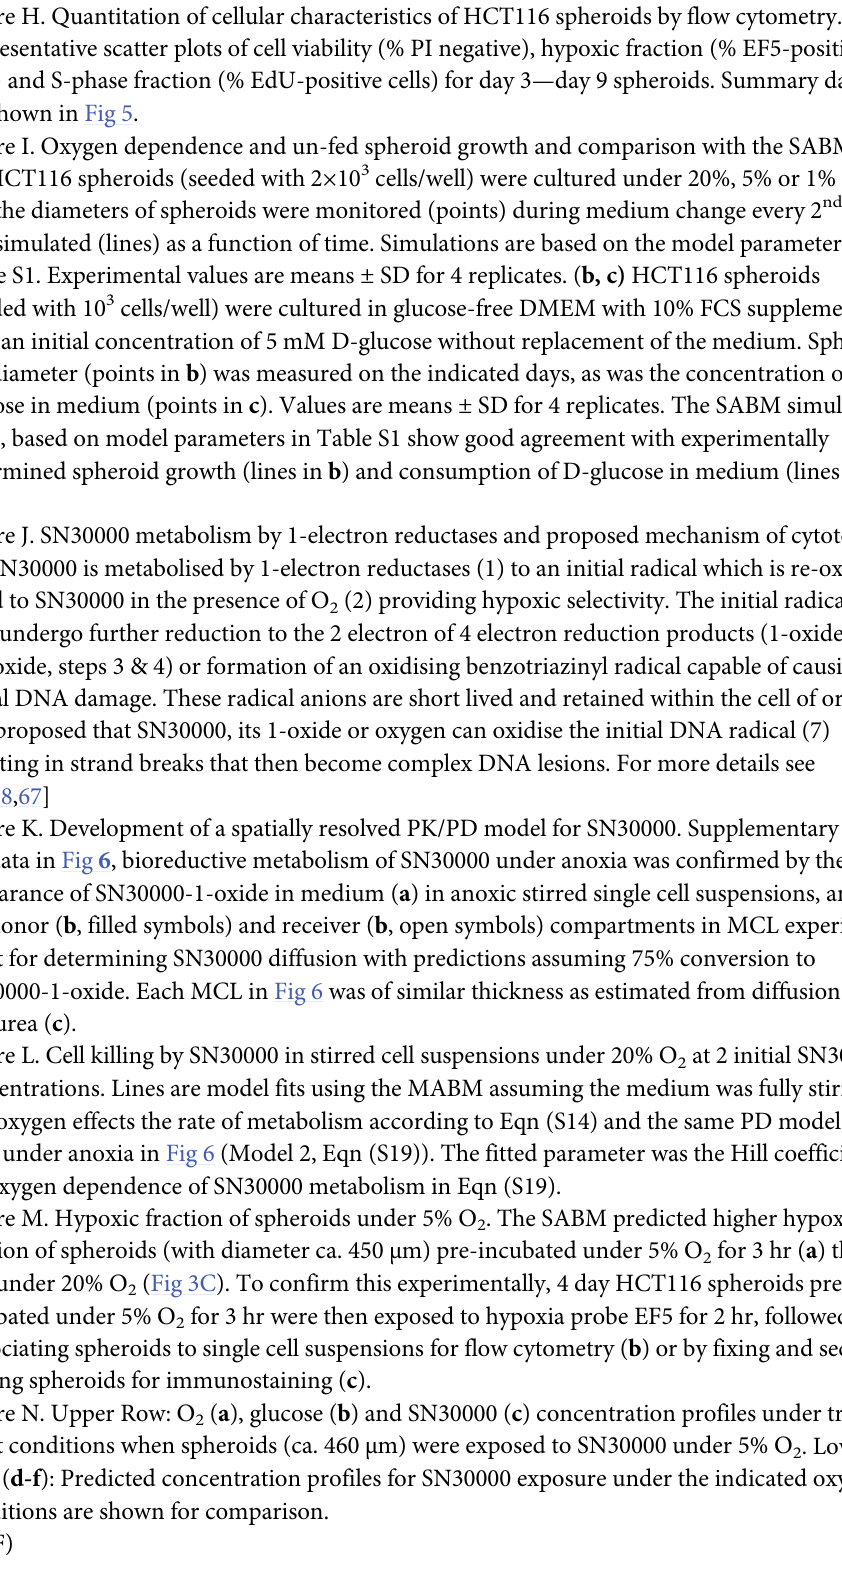
Figure H. Quantitation of cellular characteristics of HCT116 spheroids by flow cytometry. Representative scatter plots of cell viability (% PI negative), hypoxic fraction (% EF5-positive cells) and S-phase fraction (% EdU-positive cells) for day 3—day 9 spheroids. Summary data are shown in Fig 5. Figure I. Oxygen dependence and un-fed spheroid growth and comparison with the SABM.